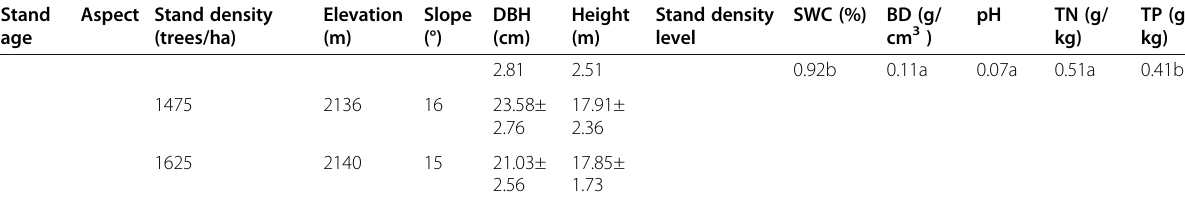
Table 1 Summary of the characteristics of the sample plots. [N40°E], [N10°E], and [N20°E] where N is the reference direction, and 40°E is the deviation from the reference direction heading east. SWC, soil moisture content; BD, soil bulk density; TN, soil total nitrogen content; TP, soil total phosphorus content; DBH, diameter at breast height; pH, hydrogen ion concentration. Values are the mean ± standard deviation (SD). Different lowercase letters (a, b, and c) indicate significant differences ( P < 0.05) between different